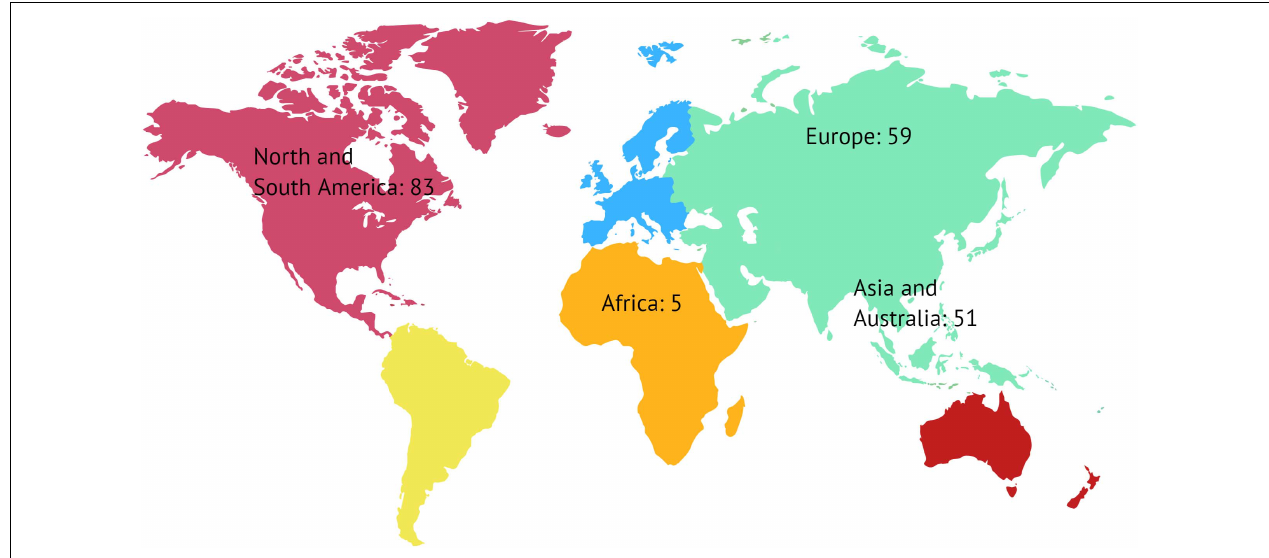
FIGURE 1 | The survey had respondents from 4 regions representing 6 continents and 59 countries.